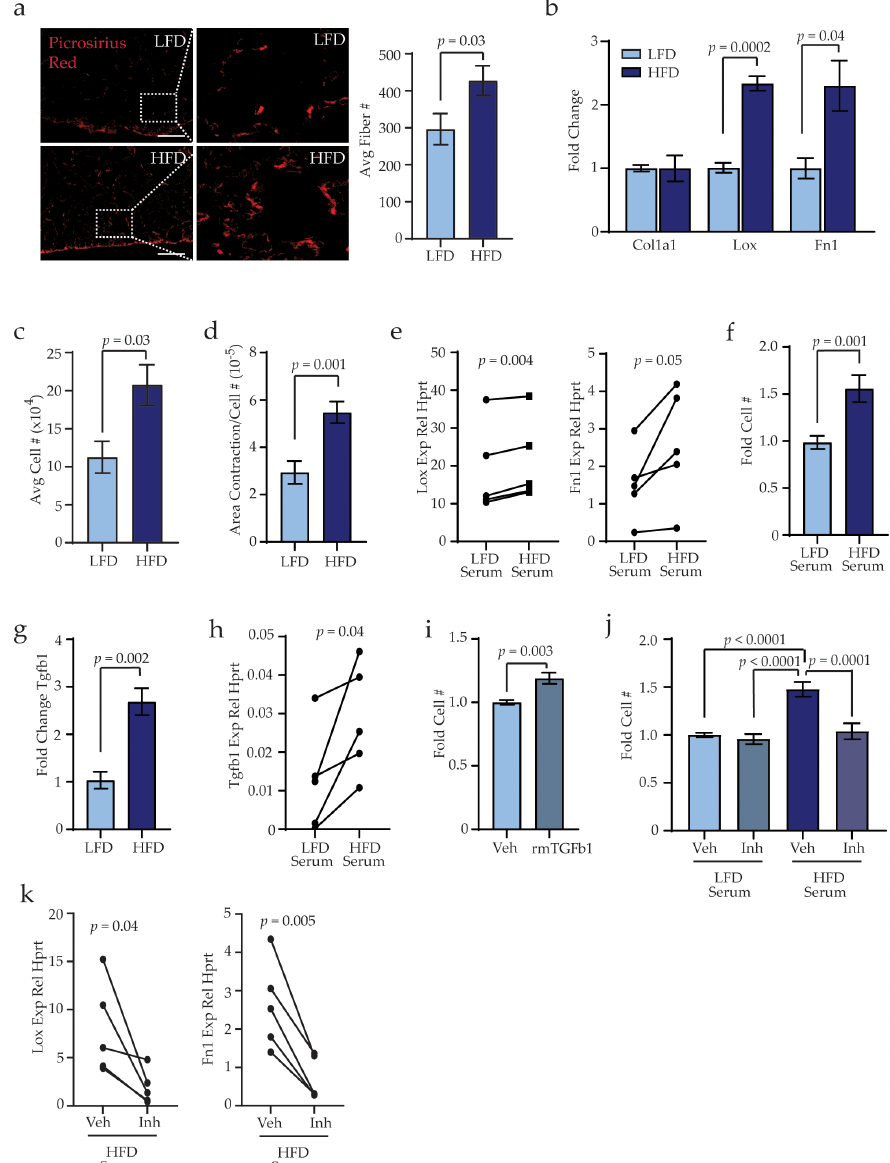
Figure 4. Obesity alters lung stromal cells within the lungs in the absence of tumor formation. ( a ) Quantification of picrosirius red-stained collagen fibers in lung sections of LFD- and HFD-fed non-tumor-bearing mice (n = 5 mice/group). ( b ) Expression of extracellular matrix (ECM) components from primary lung stromal cells. Expression differences were normalized to hypoxanthine-guanine phosphoribosyltransferase ( Hprt ) and represented as fold change from controls (n = 6 mice/group). ( c ) Cell numbers of isolated lung stromal cells grown in culture for 6 days (n = 3 mice/group). ( d ) Average area of collagen contracted from lung stromal cells (n = 3 mice/group). ( e ) Lox and Fn1 expression in lung stromal cells isolated from LFD-fed mice treated with serum from LFD- or HFD-fed mice. Represented as relative expression compared to Hprt (n = 5 mice/group; paired t-test). ( f ) Cell numbers of isolated lung stromal cells from LFD-fed mice treated with serum from LFD- or HFD-fed mice for 6 days (n = 5 mice/group). ( g ) Expression of transforming growth factor beta-1 ( Tgf β 1 ) from primary lung stromal cells. Expression differences were normalized to Hprt and represented as fold change from controls (n = 6 mice/group). ( h ) Tgf β 1 expression in lung stromal cells isolated from LFD-fed mice treated with serum from LFD- or HFD-fed mice. Represented as relative expression compared to Hprt (n = 5 mice/group; paired t-test). ( i ) Lung stromal cells from LFD-fed mice treated with vehicle (veh) or recombinant mouse (rm) TGF β 1 (n = 3 mice/group). ( j ) Lung stromal cells from LFD-fed mice treated with serum from LFD- or HFD-fed mice supplemented with veh or TGF β inhibitor (inh) SB431542 (n = 3 mice/group). ( k ) Lox and Fn1 expression in lung stromal cells isolated from LFD-fed mice treated with serum from LFD- or HFD-fed mice. Represented as relative expression compared to Hprt (n = 5 mice/group; paired t-test). Magnification bars = 50 µ